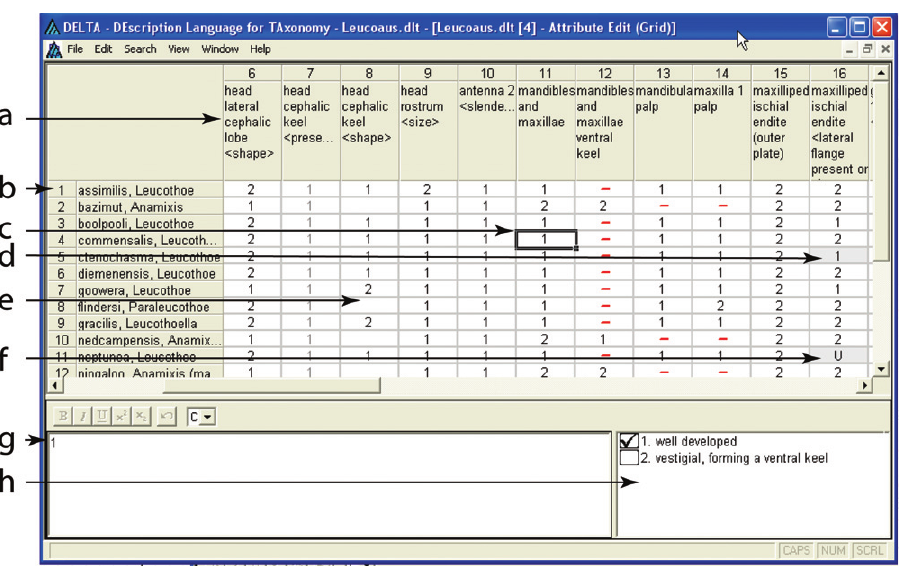
Figure 14a–h. Attribute editor in the Grid view. a character feature text b taxon list c selection box shows character state 1 selected. Th e red dash of character 12 indicates that this character is inapplicable d the grey background in the box indicates that a comment in angle brackets was made to specify the character state e unrecorded character f character states explicitly marked unknown g character state pane, where aside from the input of the character state as a number comments can be made in angle brackets h character state selection check